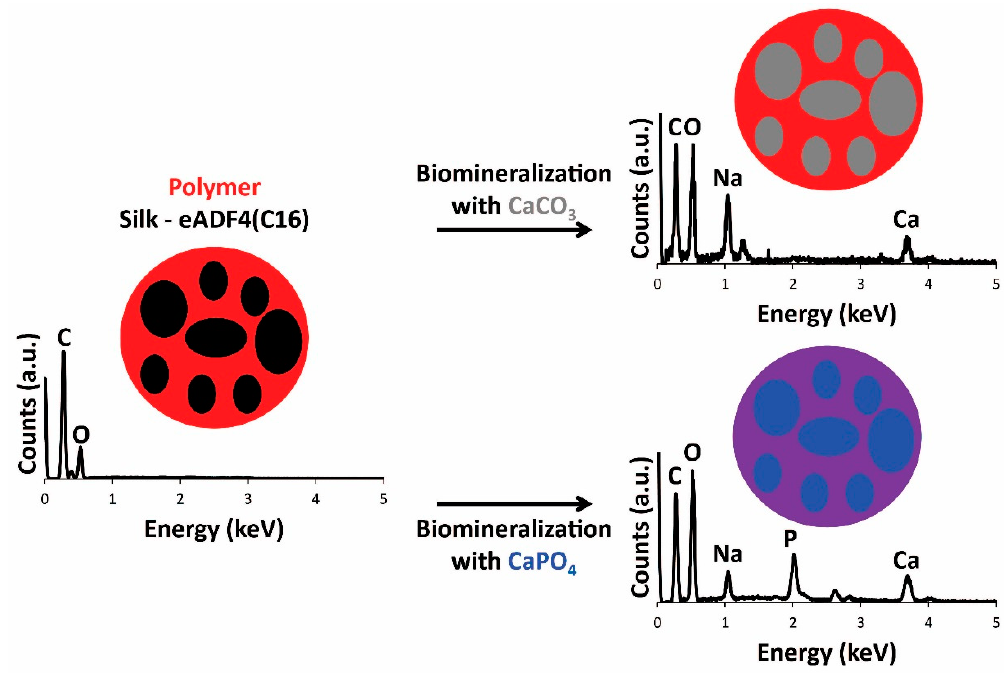
Figure 1. Schematic of the biomineralization of films with representative EDS analysis of films.